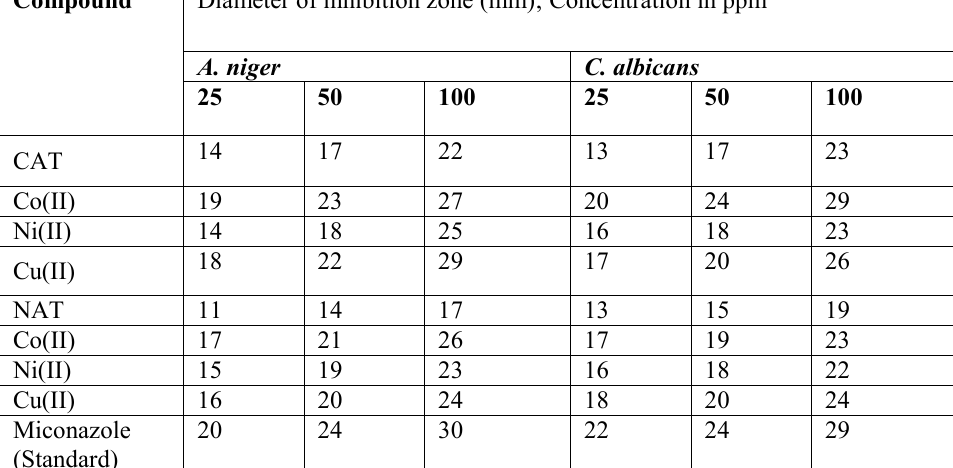
Table 4. Antifungal screening data for the ligands and their complexes.